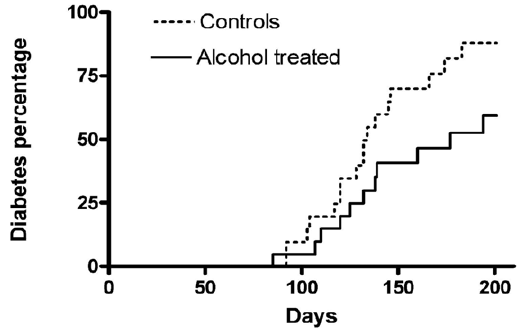
Figure 2. Ethanol reduces diabetes incidence in NOD mice. Kaplan-Meier curves showing the cumulative incidence of diabetes in alcohol treated (firm line) and in control NOD/Bom mice (dotted line). Log-rank test evaluated p , 0.05.